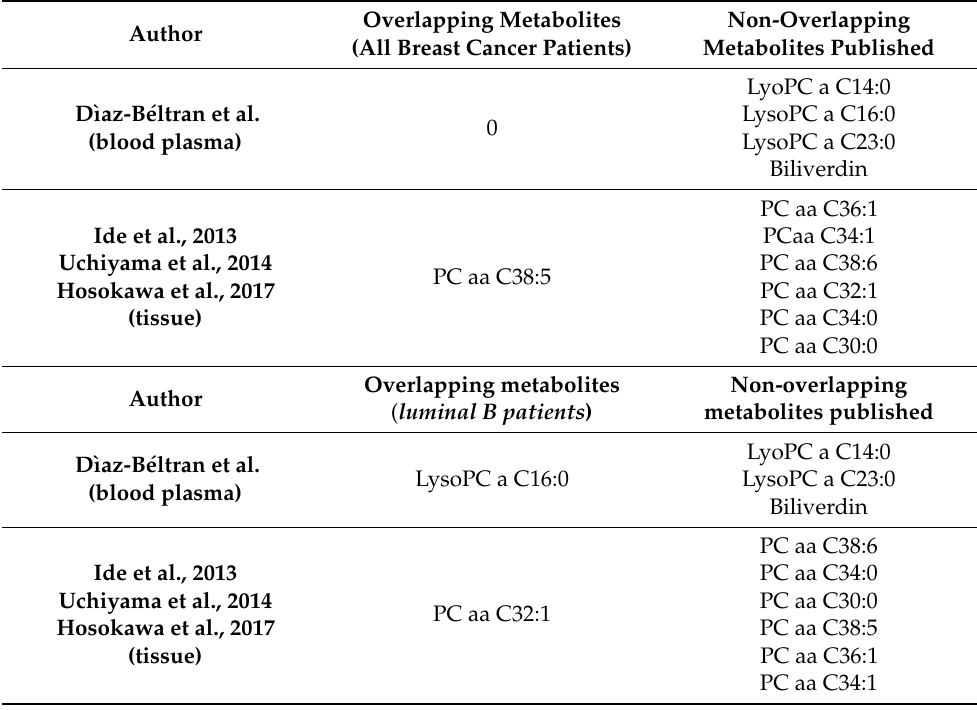
Table A4. Differentially expressed metabolites of all breast cancer patients and of the luminal B subgroup compared to the metabolic profiles already published in the